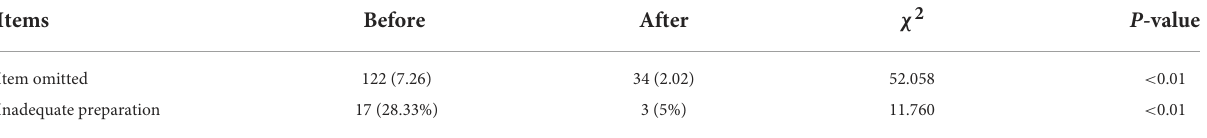
TABLE 2 Comparison of occurrence of handover events before and after using checklist [Times (%)].